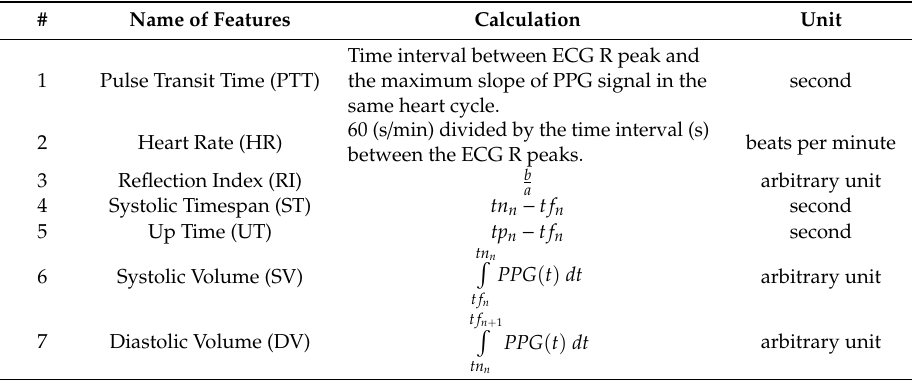
Table 1. Features extracted from the ECG and the PPG signal, together with their